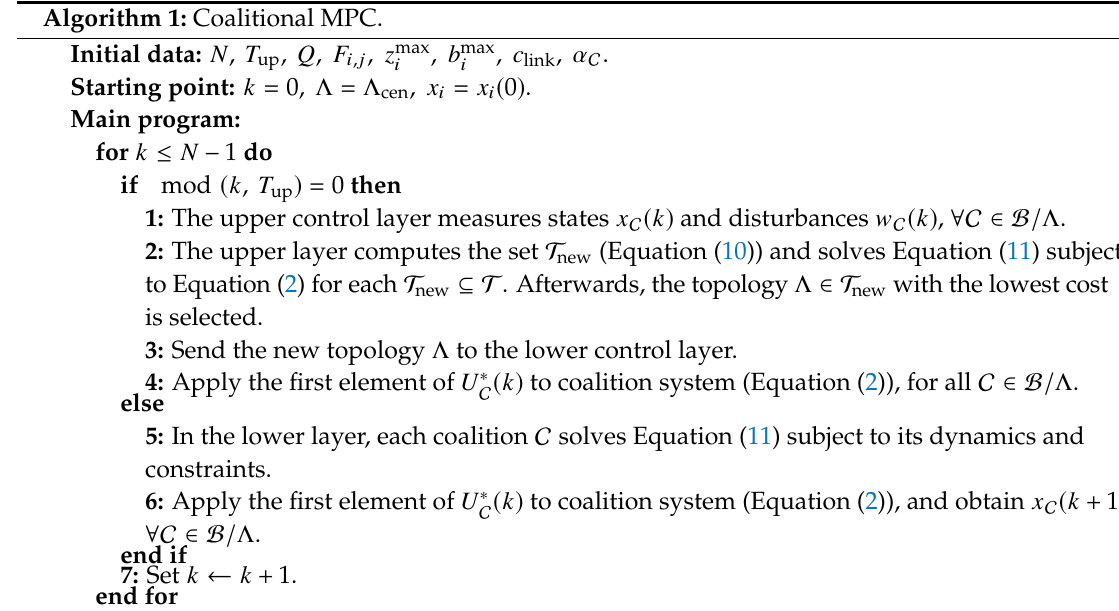
Algorithm 1: Coalitional